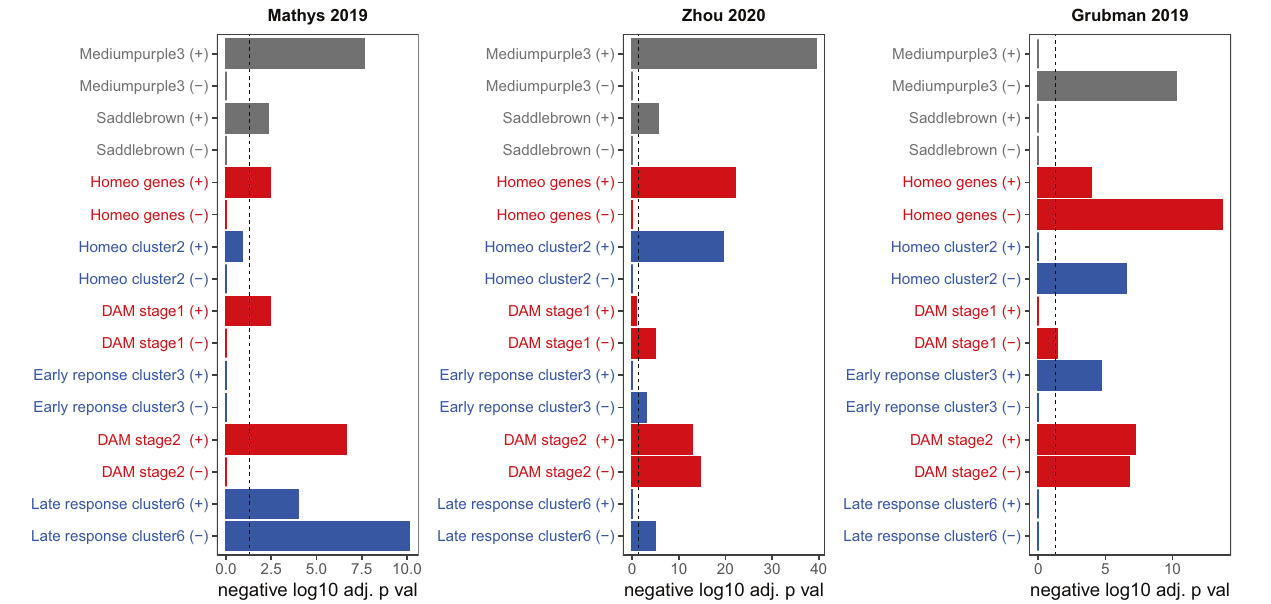
Fig. 6 Human single-nucleus microglial RNA-seq data is enriched for our NPH modules and mouse microglial gene lists. For each single-nucleus RNA- seq study, microglial genes that increased ( + ) or decreased ( − ) in AD were separately analyzed using two-sided Fisher ’ s exact test for enrichment for gene sets on the y -axis; Supplementary Data 7 has all analyses from this fi gure. The top two modules in gray ( mediumpurple3 and saddlebrown ) are NPH modules from this paper; mouse gene lists from Keren-Shaul et al. 37 (red) and Mathys et al. 38 (blue) are also shown. Mathys et al. 21 and Zhou et al. 19 both show enrichment for lists in the microglial gene set that is increasing in AD, although in both datasets there are some DAM or late-stage gene that are decreasing in AD. Similar to the fi rst two studies, Grubman et al. 22 also shows a mixed response for DAM genes. Unlike the fi rst two studies, Grubman et al. shows signi fi cant overlap of homeostatic gene sets with microglial genes that are decreasing in AD. See main text for discussion. Each study is separately Bonferroni adjusted — dotted line in all panels is p value =